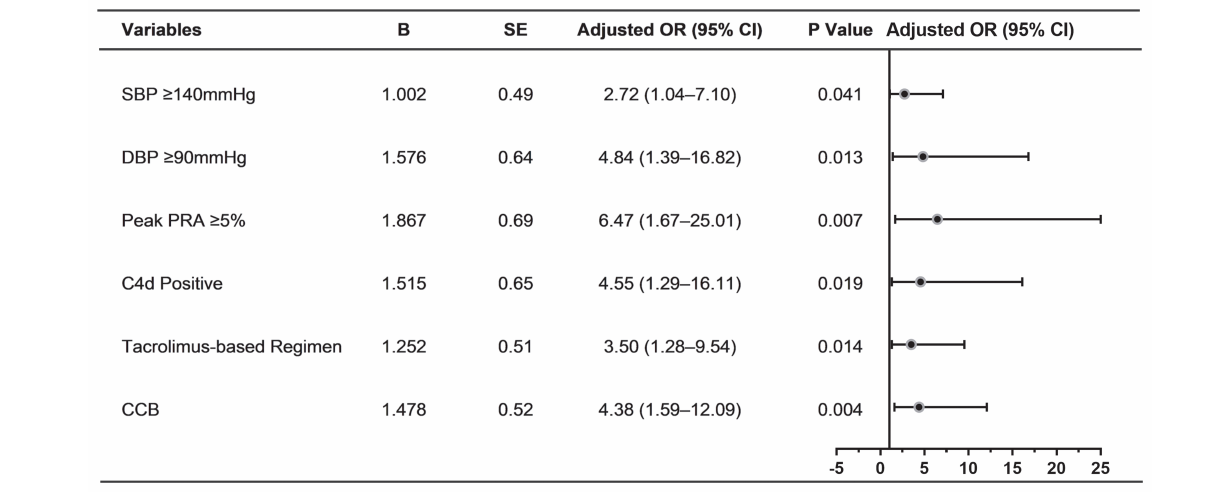
performance remained similar after adjusted for optimism in an internal validation (slope = 1.007; intercept = − 0.004) ( Figure 6